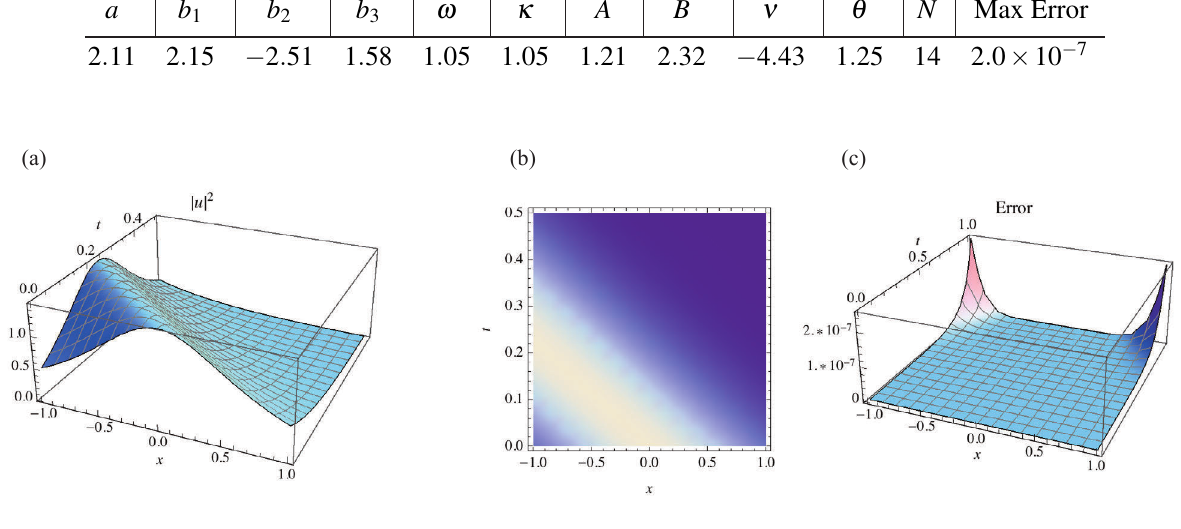
Fig. 2. Graphical representation of the results of example 2: (a) 3D bright soliton, (b) 2D density contour and (c) Absolute error with N = 14 iteration steps.